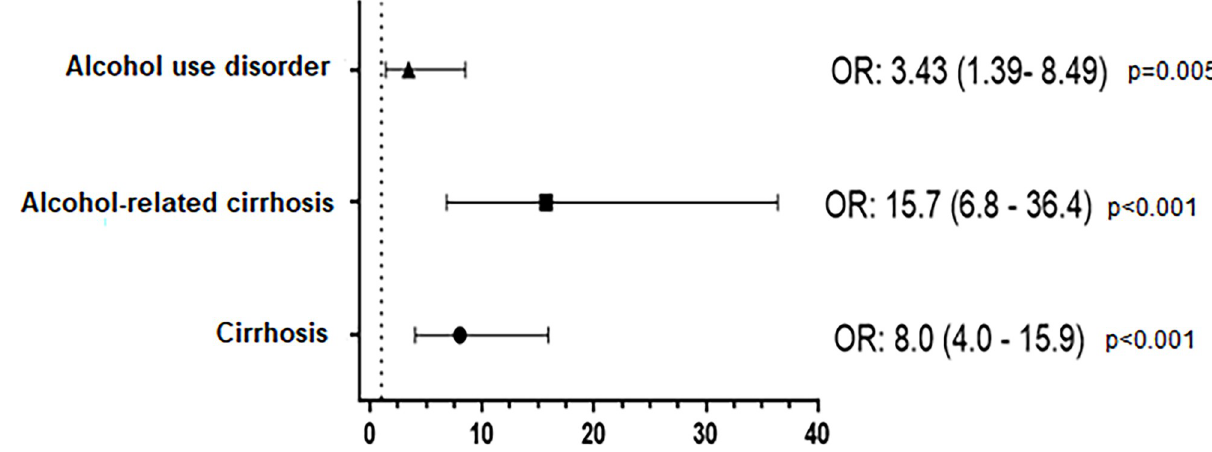
Fig 1. Associated risk factors with HEV